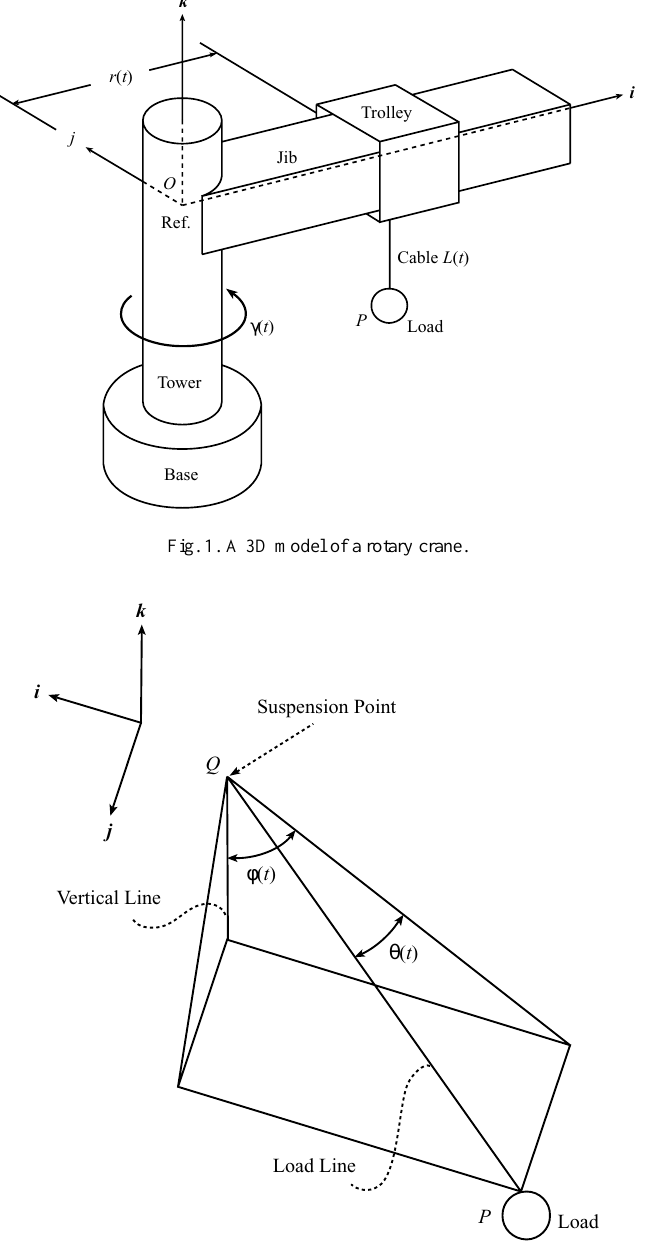
Fig. 2. Oscillation angles φ ( t ) and θ ( t ) of the